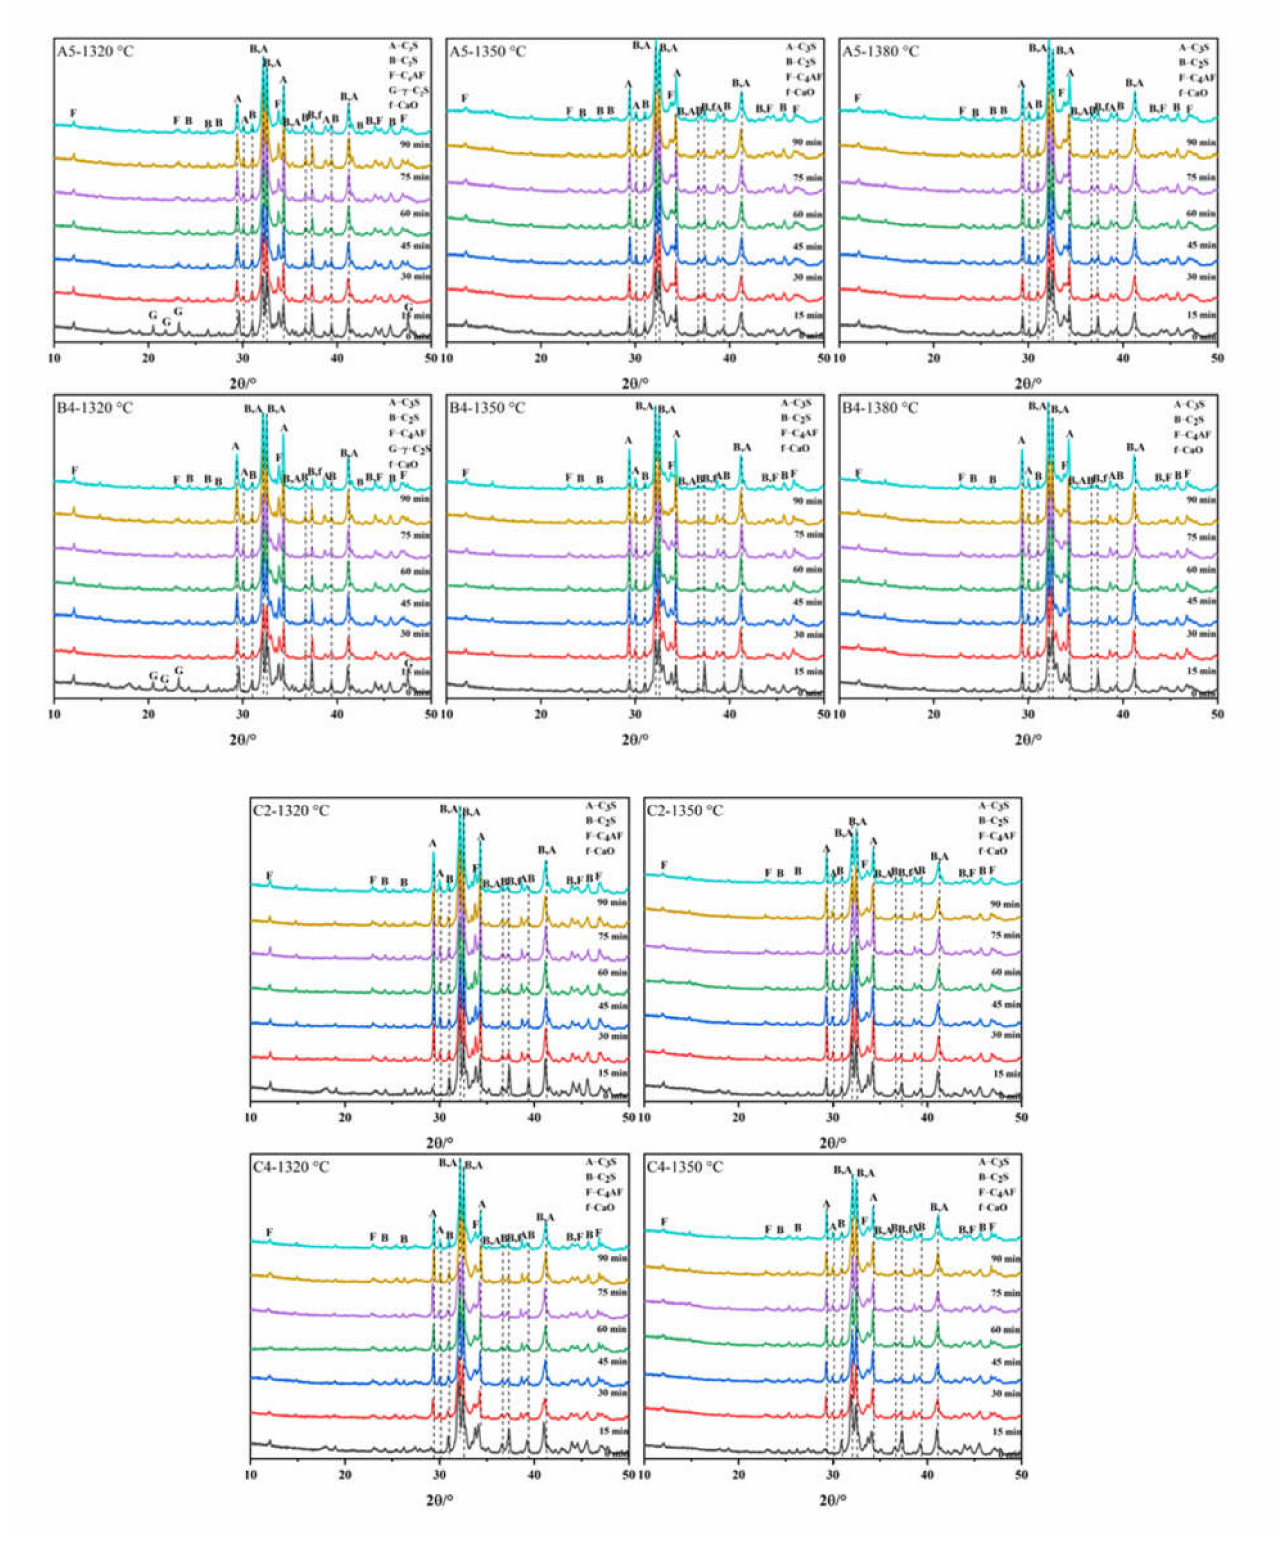
Figure 7. XRD of different clinkers at different calcination times and